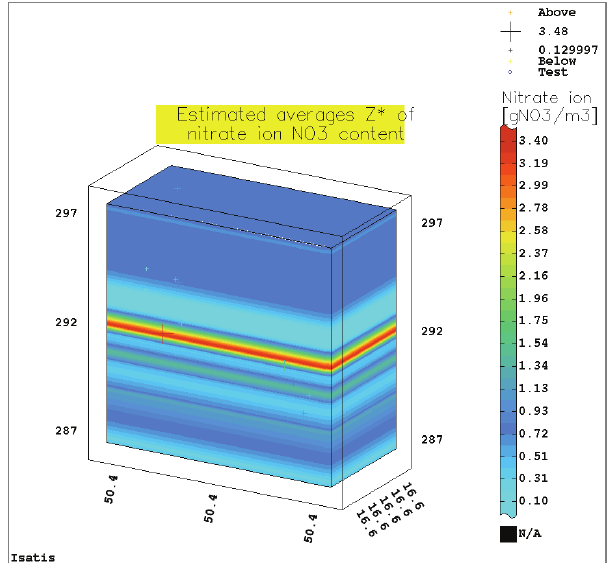
Fig. 26. Block diagram of estimated averages Z * distribution of nitrate ion content [g intake area; 14